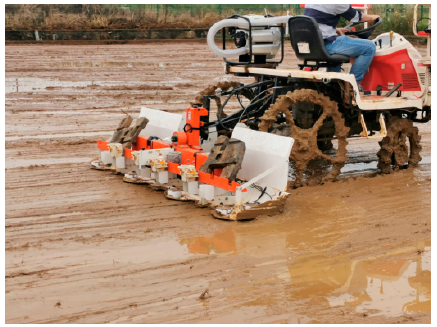
Figure 12. Experimental environment.